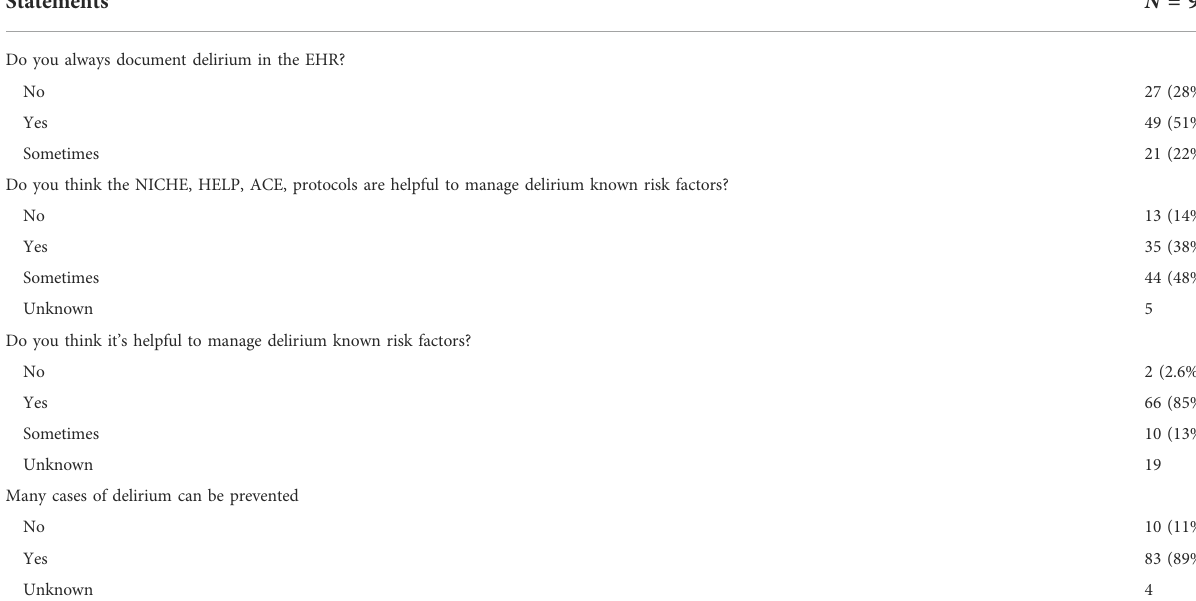
TABLE 2 Reported beliefs in delirium